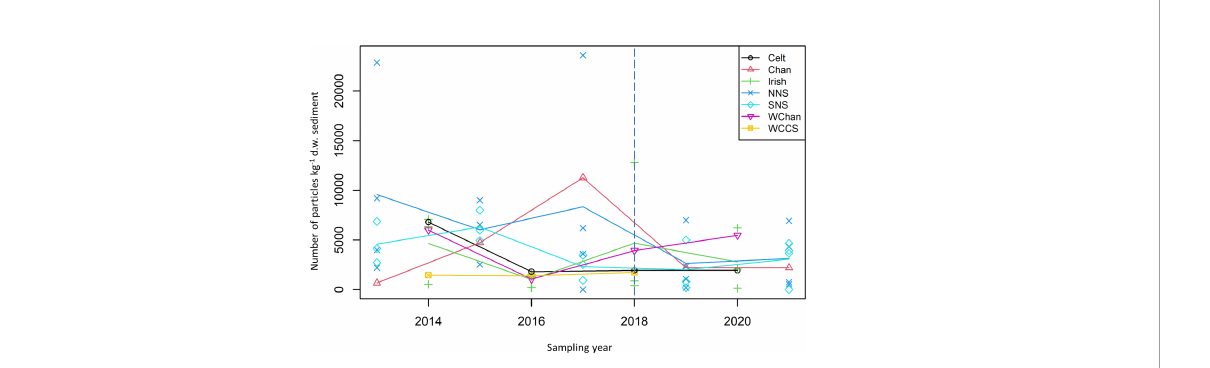
FIGURE 5 Mean number of particles kg -1 d.w. sediment plotted for UK regional seas for different years. (Celt, Celtic Seas; Chan, English Channel; Irish, Irish Sea; NNS, Northern North Sea; SNS, Southern North Sea; WChan, Western English Channel; WCCS, Western English Channel & Celtic Seas). Blue line indicates change in sampling method from the use of archive samples to dedicated microplastic samples.